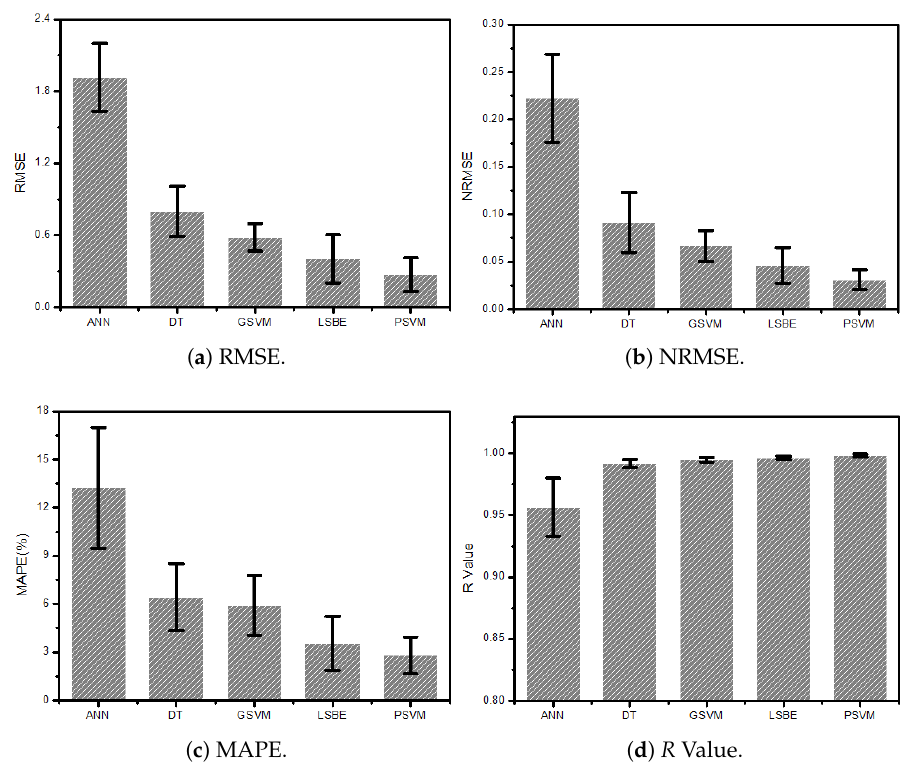
Figure 9. Comparison of different machine learning algorithms for flashover voltage: ( a ) RMSE, ( b ) NRMSE, ( c ) MAPE, ( d ) R